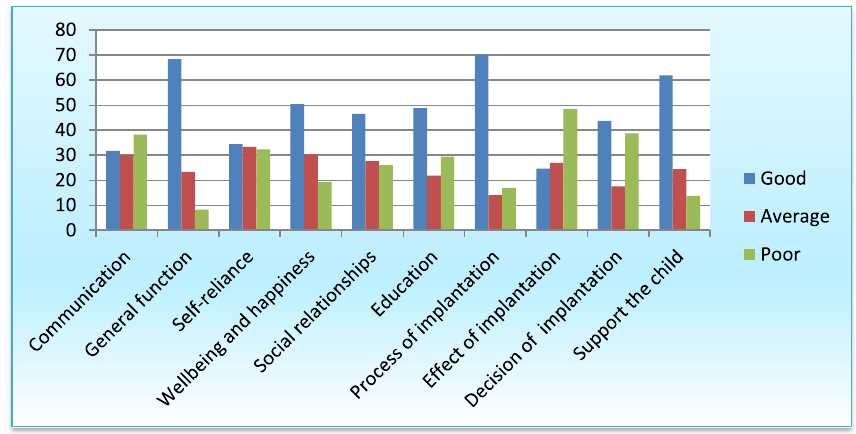
Fig. 3 Distribution of children according to their answers of the PVECIQ-Arabic version domains